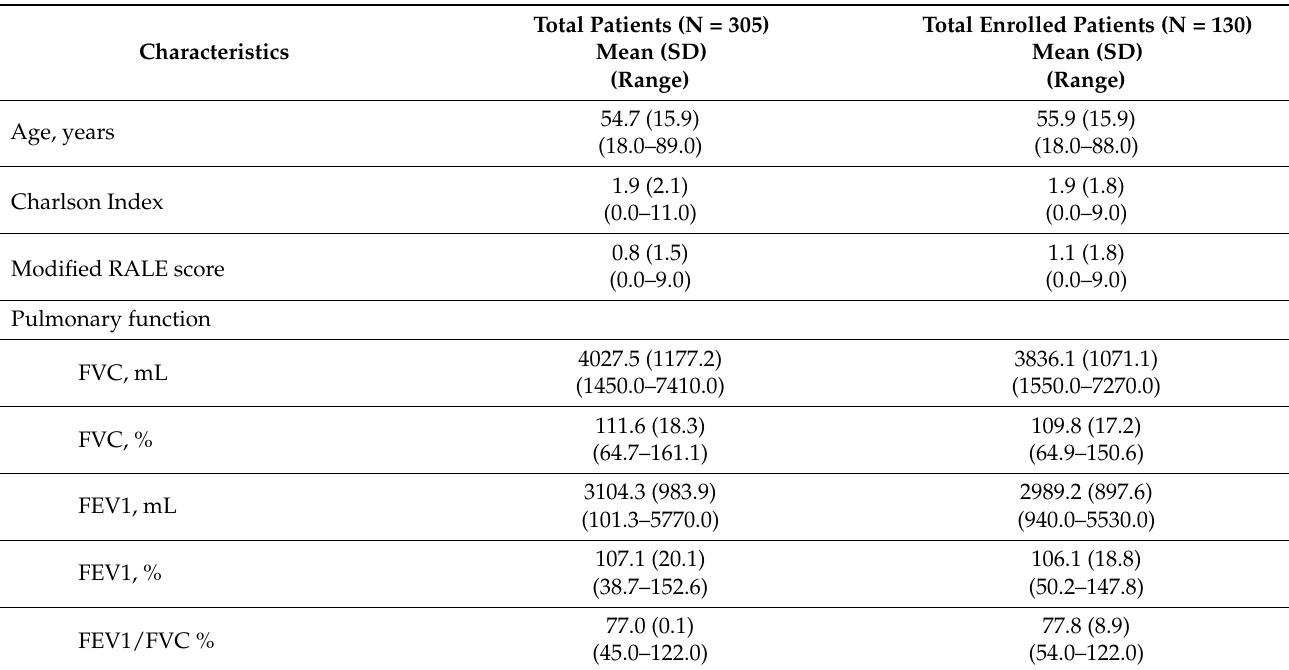
Table 2. Characteristics of enrolled patients. Quantitative